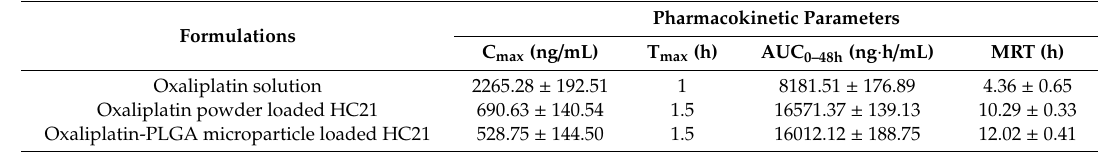
Figure 4. Plasma concentration-time profile of Pt in rats after intra-peritoneal administration of oxaliplatin powder and oxaliplatin-PLGA microparticles-loaded in HC21 hydrogel, and oxaliplatin solution. Data are expressed as the Mean ± standard deviation (n = 5). *, p < 0.05 represents a significant difference, two-sided RM ANOVA and Bonferroni test. Table 3. In vivo pharmacokinetic parameters after intra-peritoneal administration to rats (n = 5).